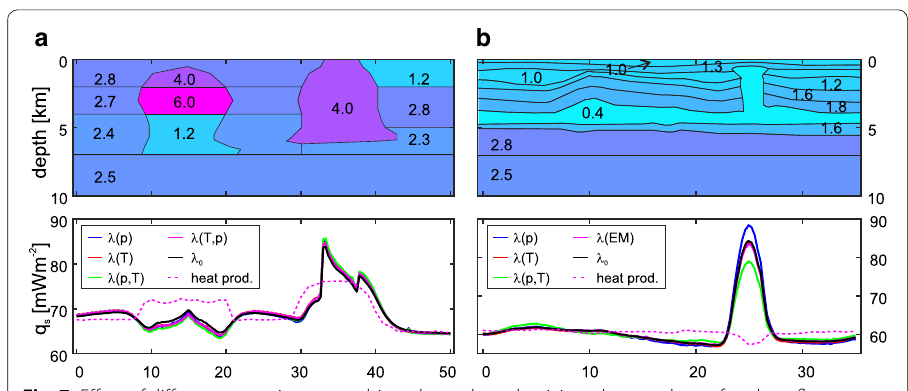
Fig. 7 Effect of different corrections on ambient thermal conductivity values on the surface heat flow assuming a basal heat flow of 30 mW m − 2 at 30 km depth. a For igneous cross section, b for sedimentary section with specific p / T corrections for thermal conductivity λ (see Table 2). λ ( p ): only p correction of λ ; λ ( T ): only T correction of λ ; λ ( p , T ): first p , then T correction of λ ; λ ( T , p ): first T , then p correction; λ (EM): correction of λ according Emirov et al. (2017) for sediments; λ 0 : without any λ correction; heat prod.: crustal heat flow calculated by the heat production H of the model layers. The specific values for H in µW m − 3 are given for each polygon in the cross sections (upper part of A and